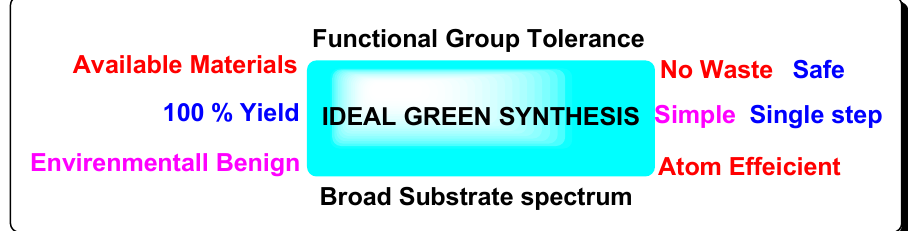
Figure 3. Characteristics of ideal green synthetic approach.